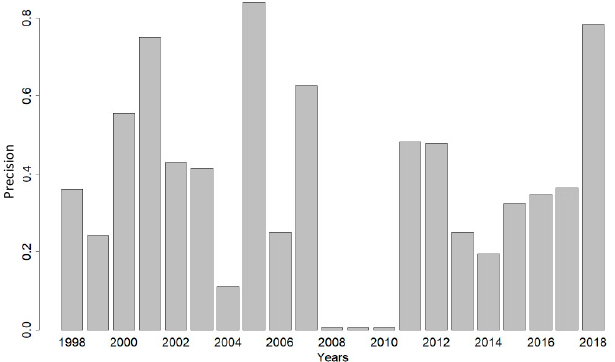
Figure 8. Contour plots of K. brevis probability as a function of combinations of riverine nutrient loads, obtained from the sensitivity analysis using the RVM. Left panel: Hillsborough and Peace River total nitrogen (TN). Right panel: Hillsborough and Caloosahatchee total phosphorus (TP).